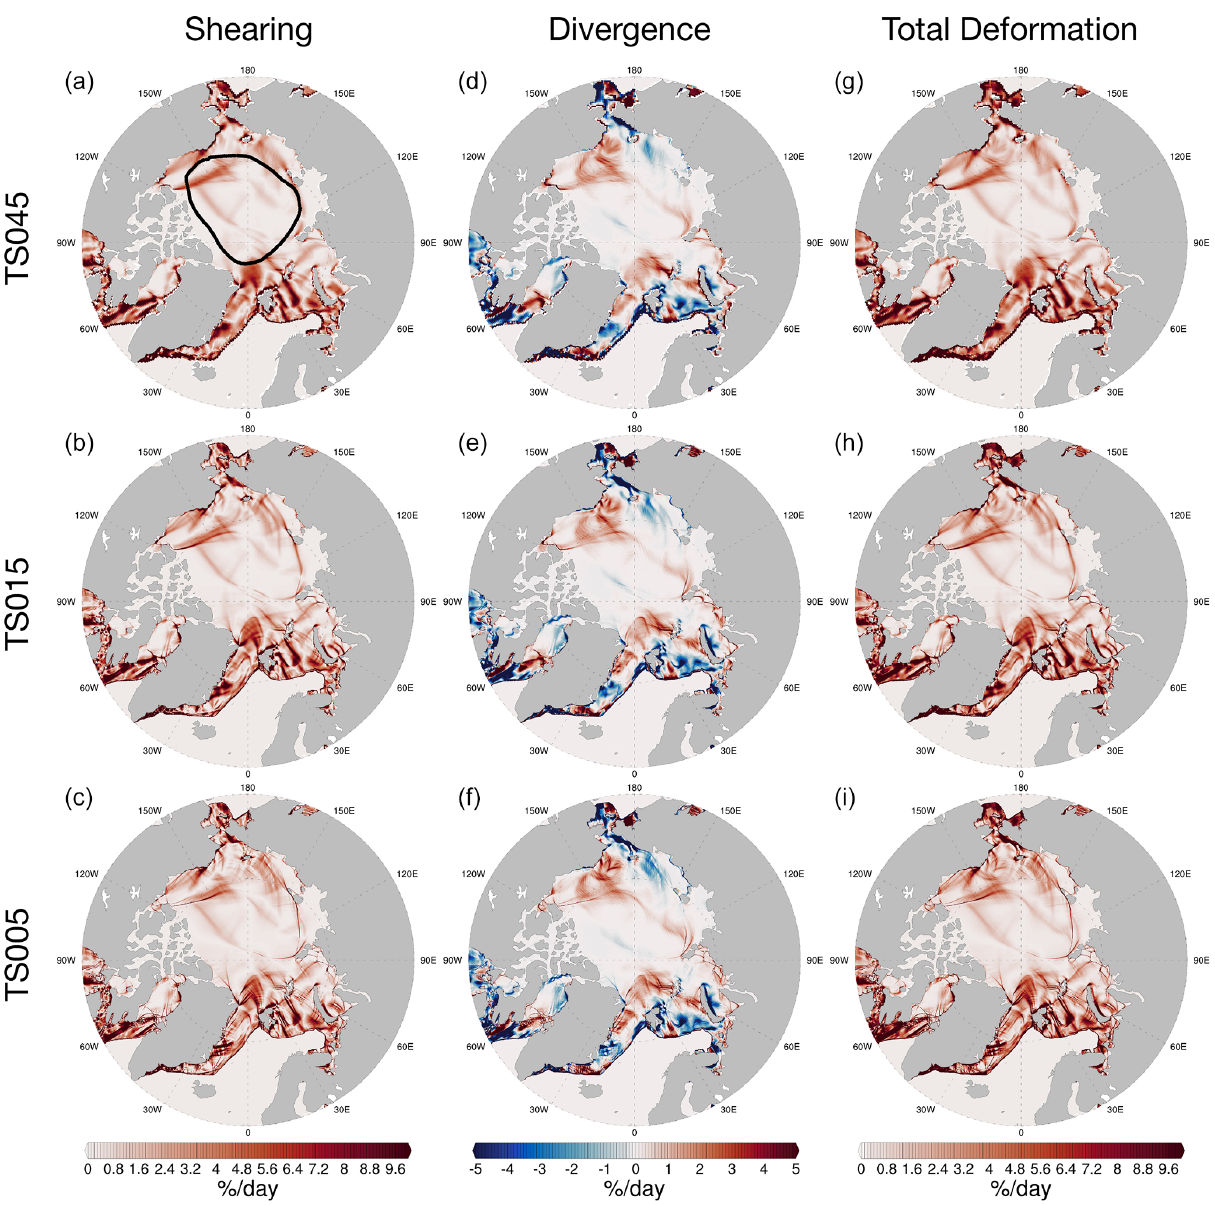
Figure 7. Daily deformation fields on 20 December. The first, second, and third rows show the deformation fields for TS045, TS015, and TS005, respectively. Deformation rates include shearing rate (a–c) , divergence rate (d–f) , and total deformation rate (g–i) . The region for further statistical analysis including spatial scaling is outlined in black in the first panel. All results are based on experiments with NDTE =